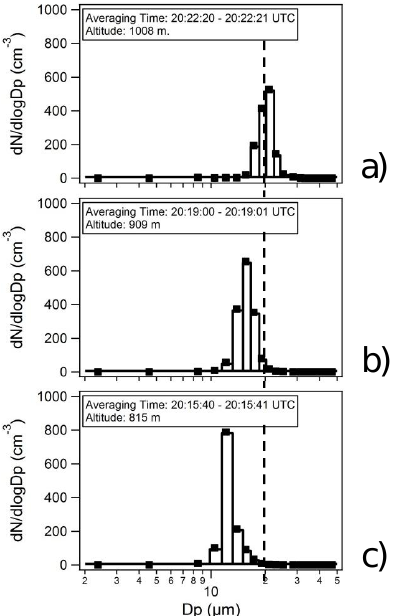
Figure 4. Monomodal cloud droplet size distributions from Flight 11 on 15 May 2012. Note the linear scale of the ordinates with the dashed line marking the 20µm diameter. A continuous increase of the droplet particle diameter with increasing altitude from (c) to (a) is